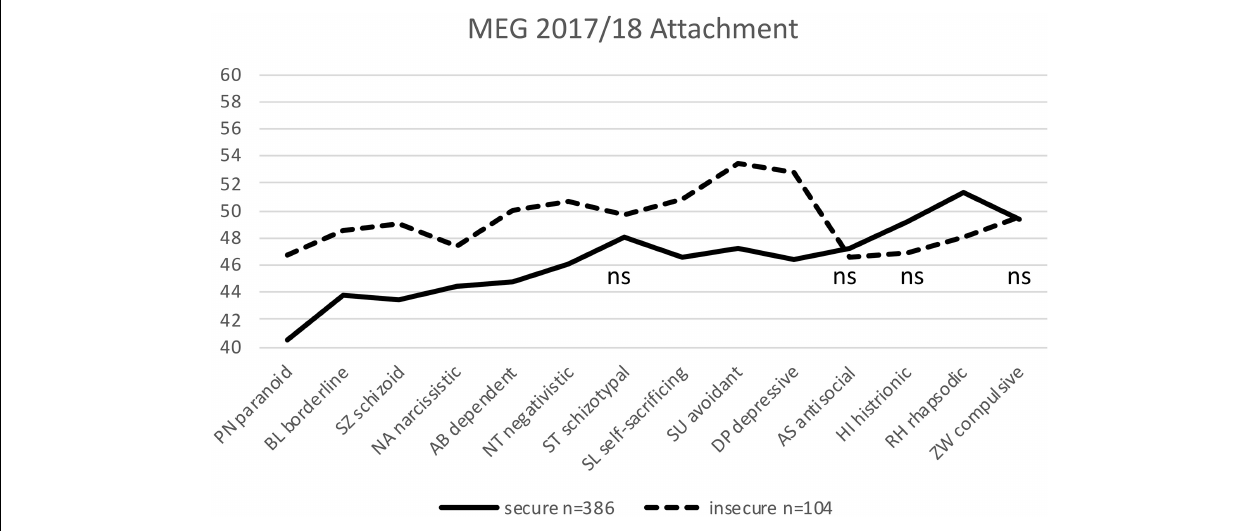
FIGURE 4 | Significant differences between 386 securely and 104 insecurely attached HYP MEG participants in 10 of 14 personality styles. The non-significant differences are labeled ns ( t- values are plotted on the y -axis; mean is t = 50; normal range is between t = 40 and t = 60; ns: not